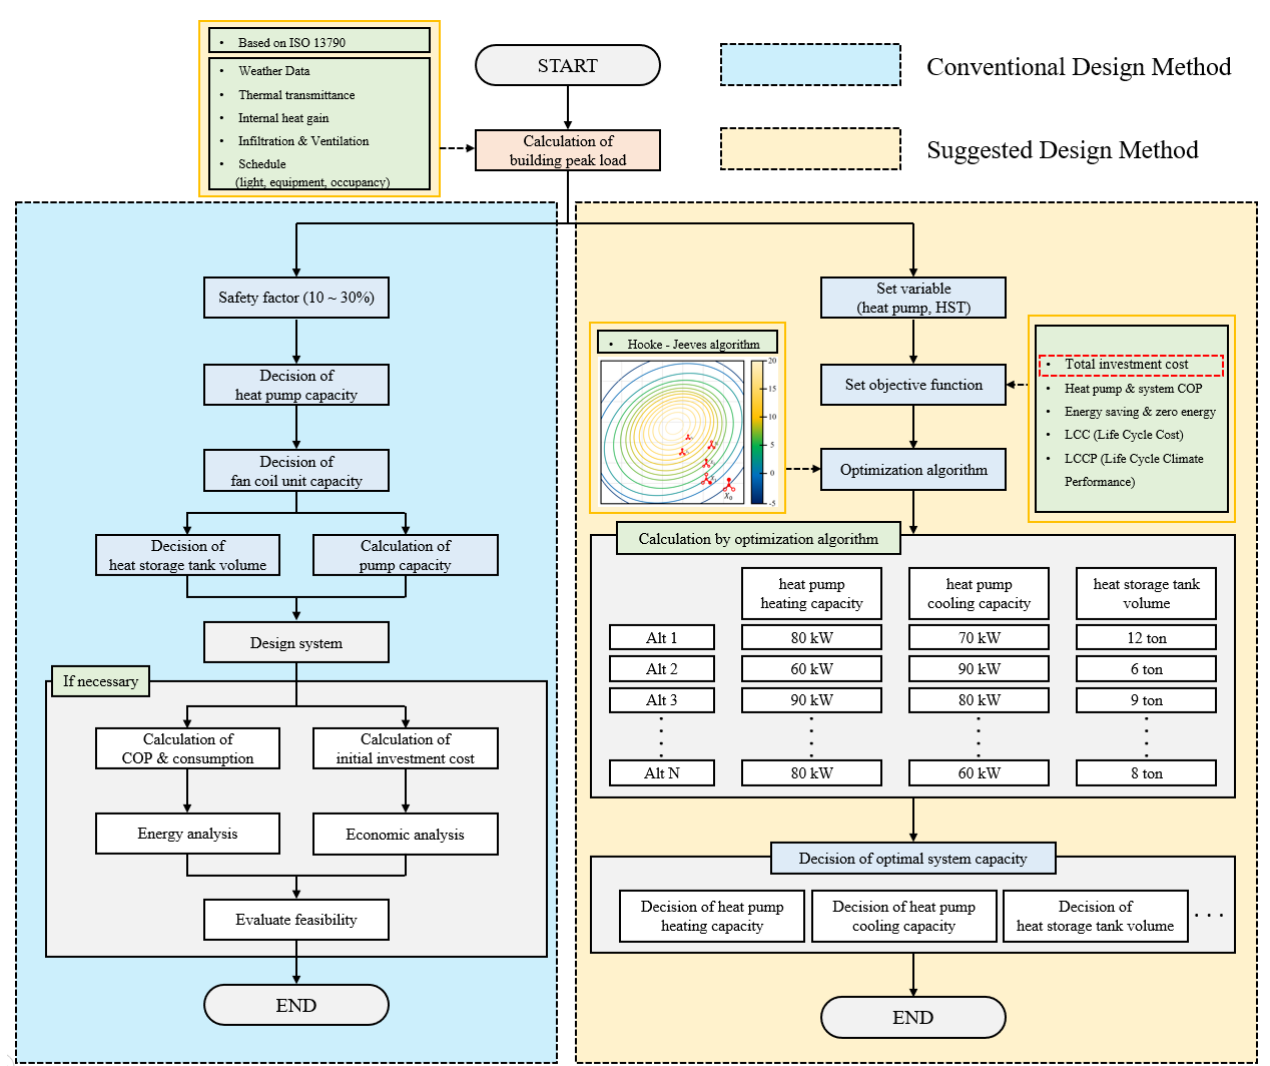
Figure 3. Flow charts of the conventional and proposed optimum design methods.